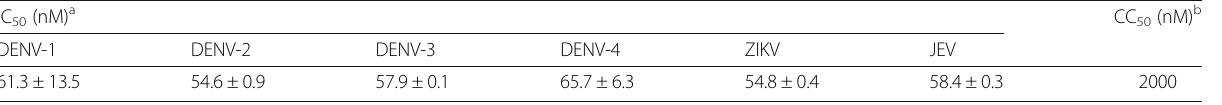
All calculation was performed by using GraphPad Prism software. All values are the results from two independent experiments — 50% inhibitory concentration of BFA were calculated from the results of the virus titer determined by focus-forming assay a IC 50 — 50% cytotoxic concentration of BFA were calculated from the dose-response curve b CC 50